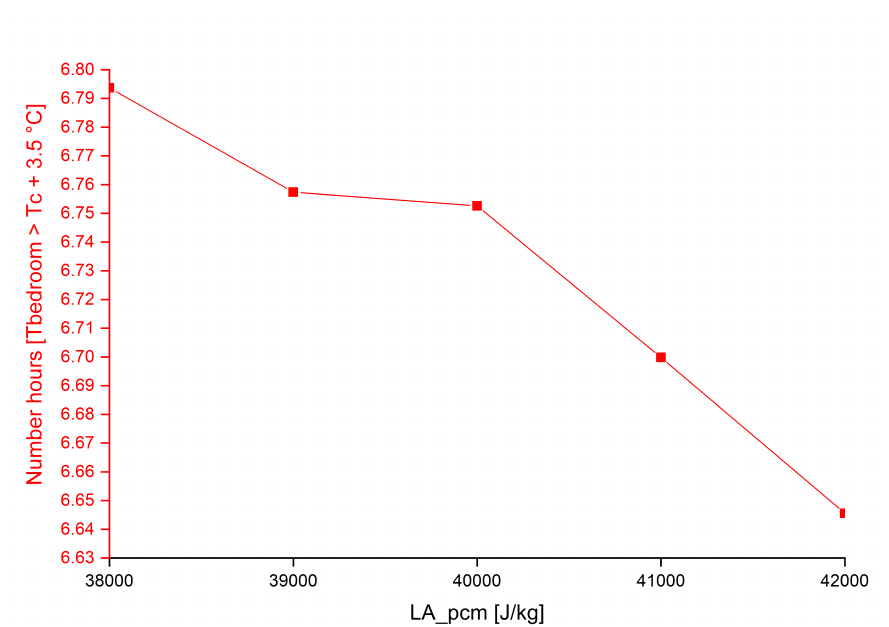
Figure 19. Number of hours of thermal discomfort vs. latent heat parameters lying close to the upper bound of 40,000